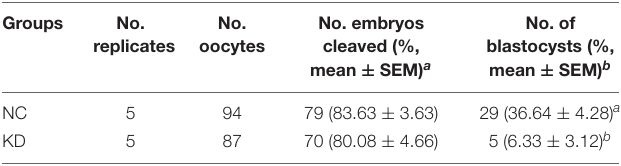
TABLE 3 | The developmental potential of early embryos depleted of SIN3A in pigs.